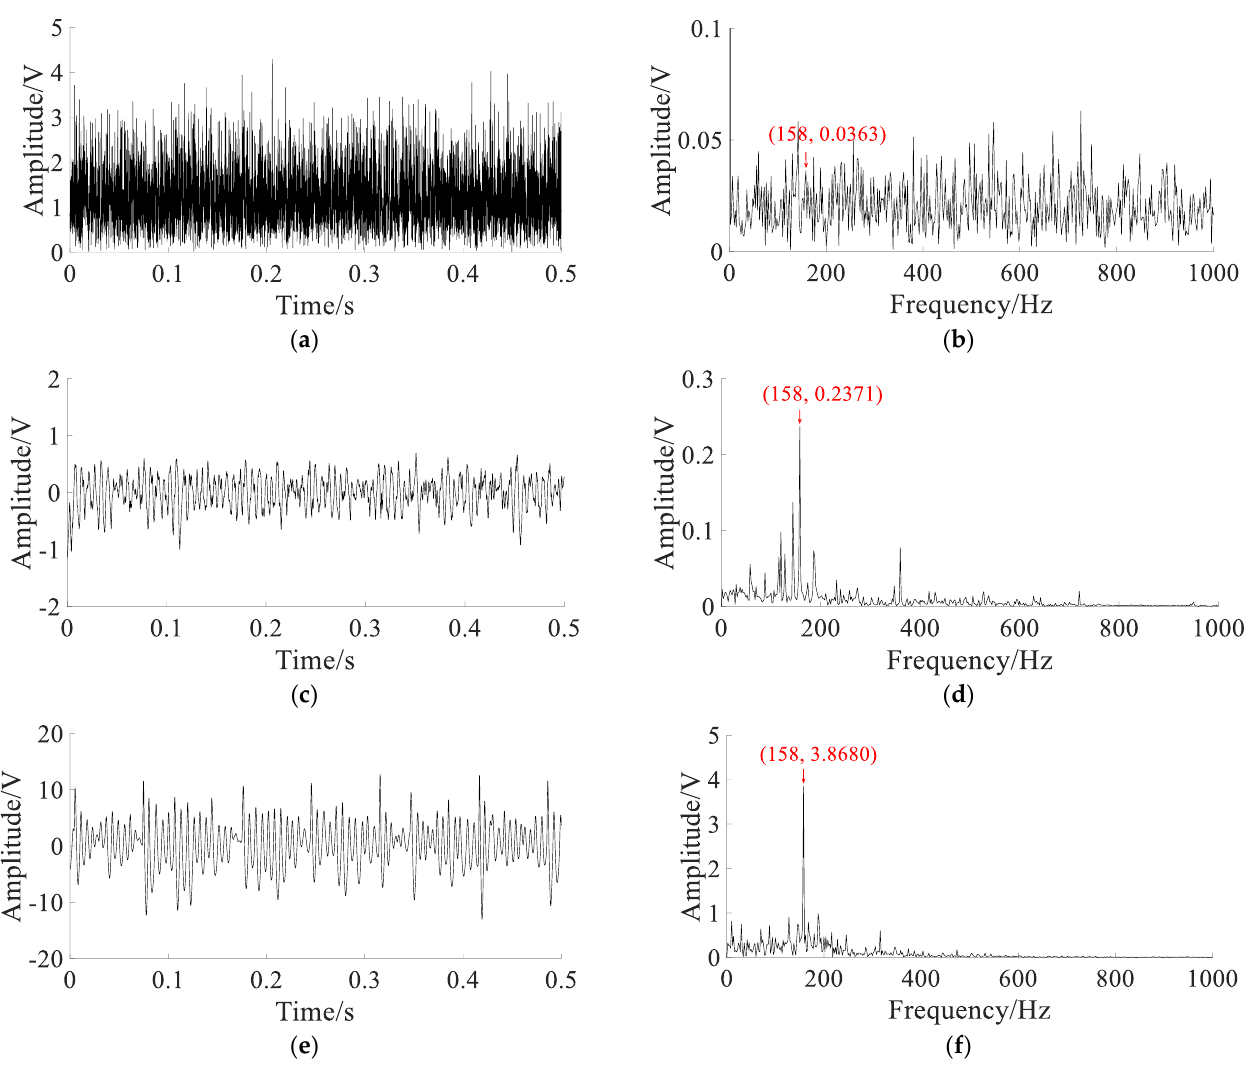
Figure 16. The results of analyzing the bearing inner ring fault signal of the CWRU using different methods: ( a ) Hilbert transform envelope demodulation signal; ( b ) Hilbert envelope spectrum; ( c ) output signal of SGST adaptive SR: a = 0.1952, b = 0.6218, m = 3500, γ = 0.0362; ( d ) output signal spectrum of SGST adaptive SR; ( e ) output signal of SAFRM adaptive SR: R = 3500, γ = 0.0927, ε = 0.2618; ( f ) output signal spectrum of SAFRM adaptive